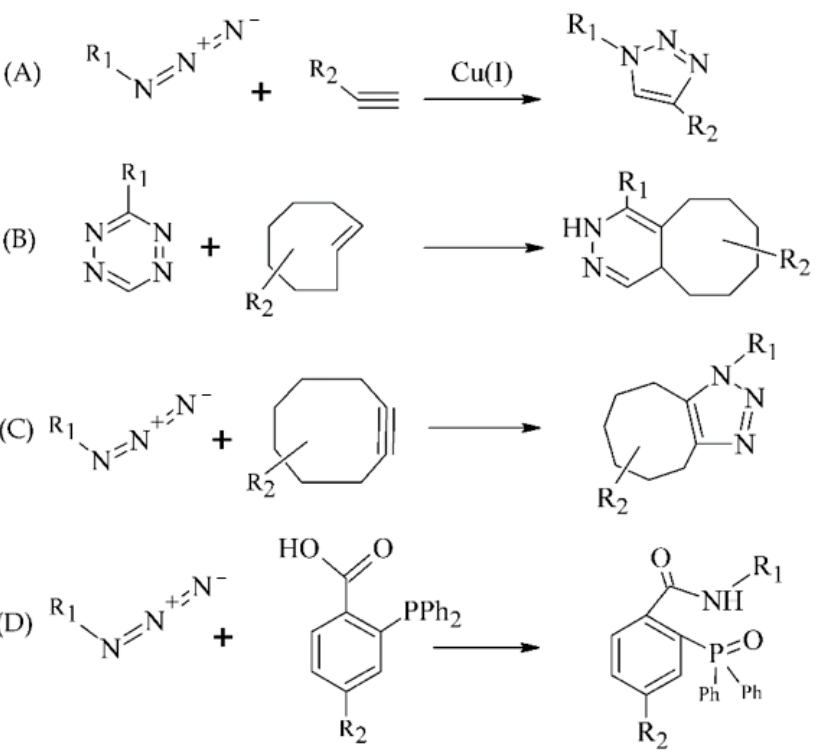
Figure 7. Selected click reactions for the preparation of intermediates used for metal chelating (R 1 , R 2 —proper chelating and peptide moieties). ( A ) CuAAC, ( B ) IEDDA, ( C ) SPAAC, ( D ) Staudinger ligation.